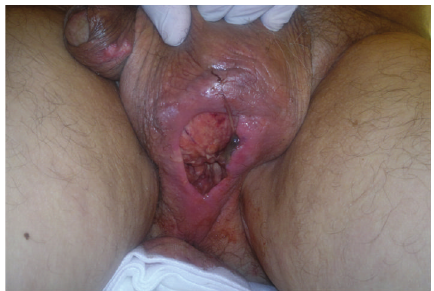
Figure 1: Perineal wound.